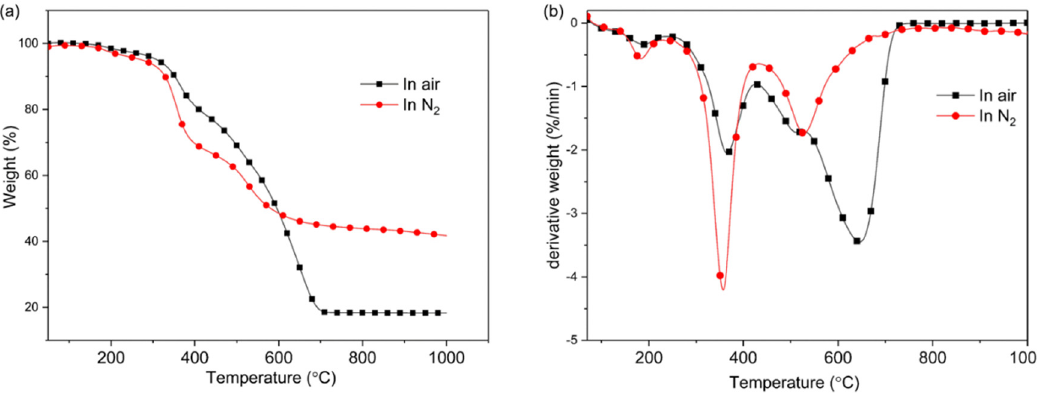
Figure 5: TG and DTG curves of POSS - 8Phenol in air or N 2 : ( a ) Weight - temperature curve ( TG ) ; ( b ) Derivative weight - temperature curve ( DTG )